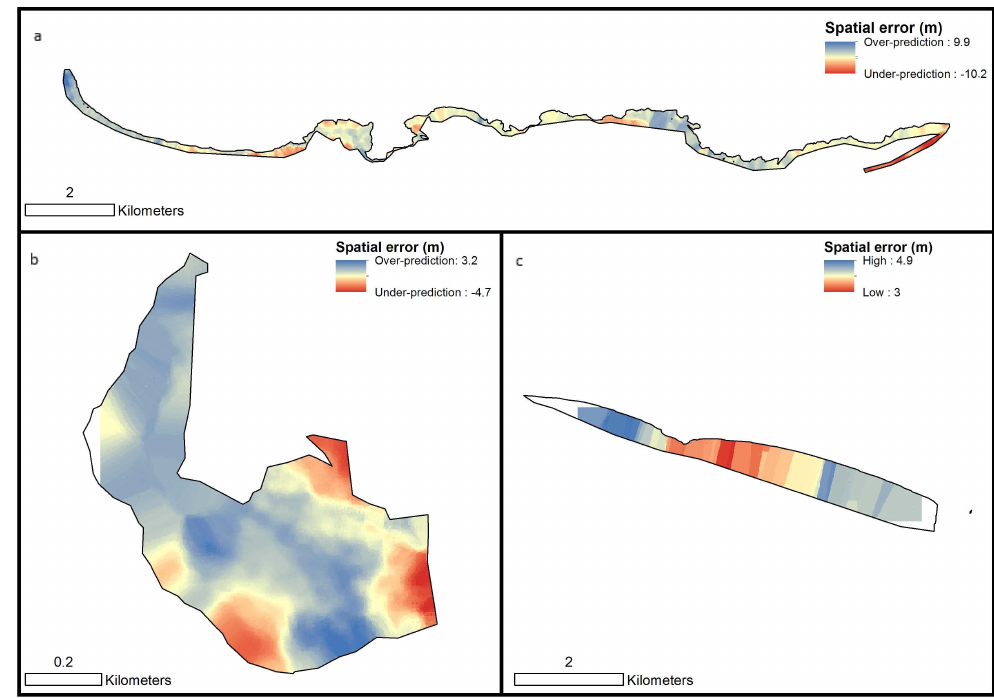
Figure 7. Spatial distribution of model residuals of the SDB maps with the highest accuracy. ( a ) the training site (National Samaria Park, 25-m maximum depth); ( b , c ) the two validation sites—Apokoronas in panel b (25-m maximum depth) and Thermaikos in panel c (12-m maximum depth). Note that the upper and lower left ramps indicate over- and under-prediction (as the difference between satellite-derived and in situ bathymetry), while the lower right ramp depicts high to low spatial error (both